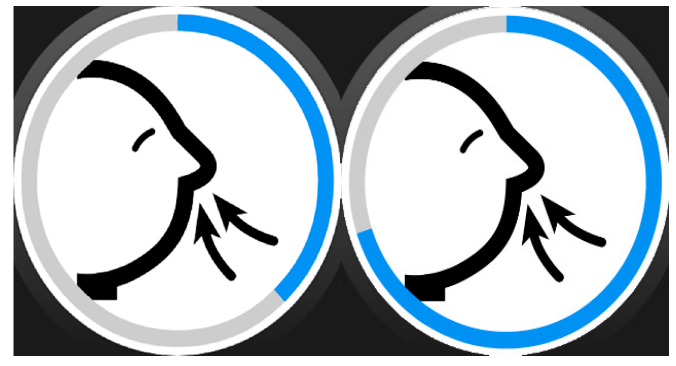
Figure 5. Pictograms for step ‐ by ‐ step breathing with round timeout.